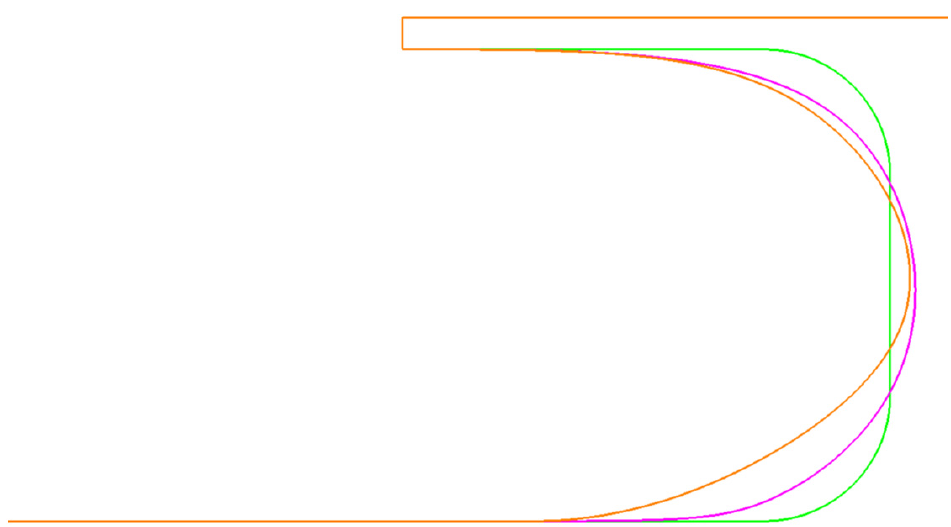
Figure 10. Comparison of geometries—initial (green), intermediate (purple), optimized (orange).